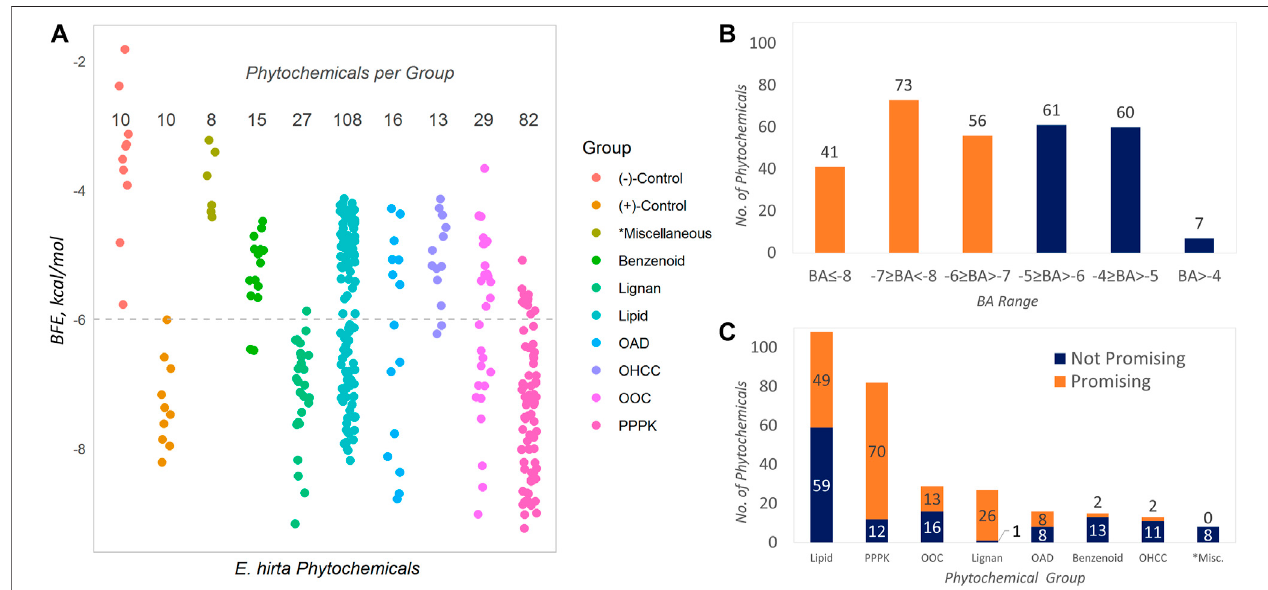
FIGURE 1 | Binding properties of the phytochemicals from E. hirta against SARS-CoV-2 main protease. Benzenoids contain the benzene ring; hydrocarbons are composed of H and C atoms only; lignans contain dimeric phenylpropanoids; lipids contain isoprene moiety (terpene or terpenoids), fatty acyls, and derivatives; OADs contain the acyl group; OOCs contain oxygen atoms (e.g., alcohols and esters); OHCC, heterocyclic ring; PPPK, Ph-C3- and alternating — (C=O)-CH 2 -. *Miscellaneous groups are composed of the least abundant